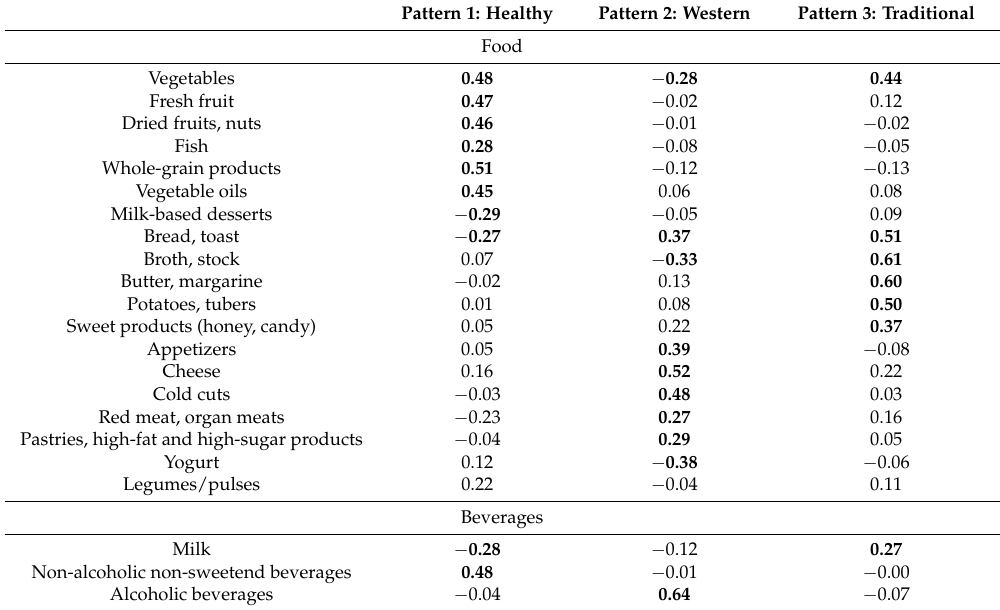
Table 1. Factor loadings of 22 food and beverage groups onto three dietary patterns (Etude